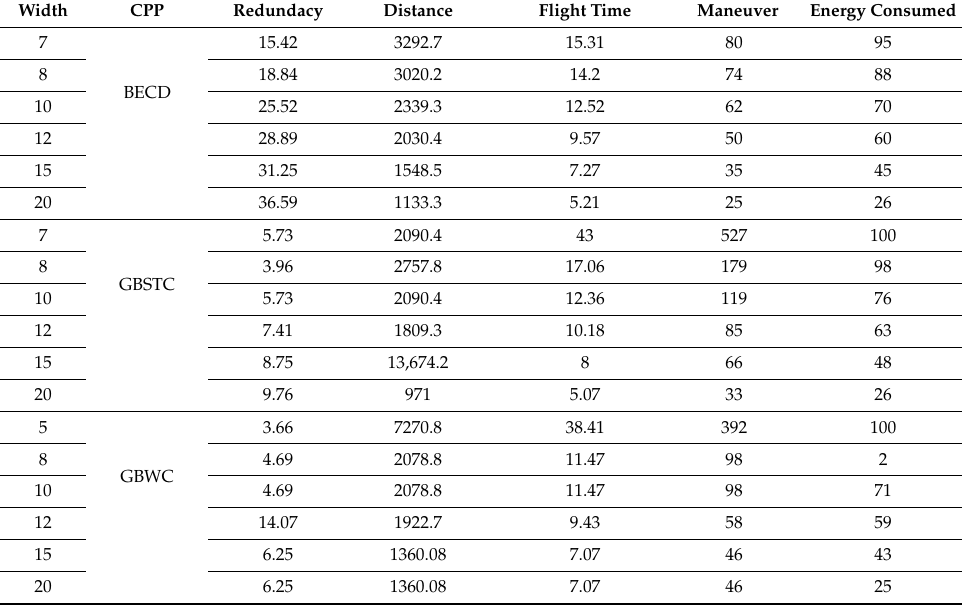
Table A7. Experiment 5 with three CPP methods implemented using the UAV 3DR Iris over Arak PV